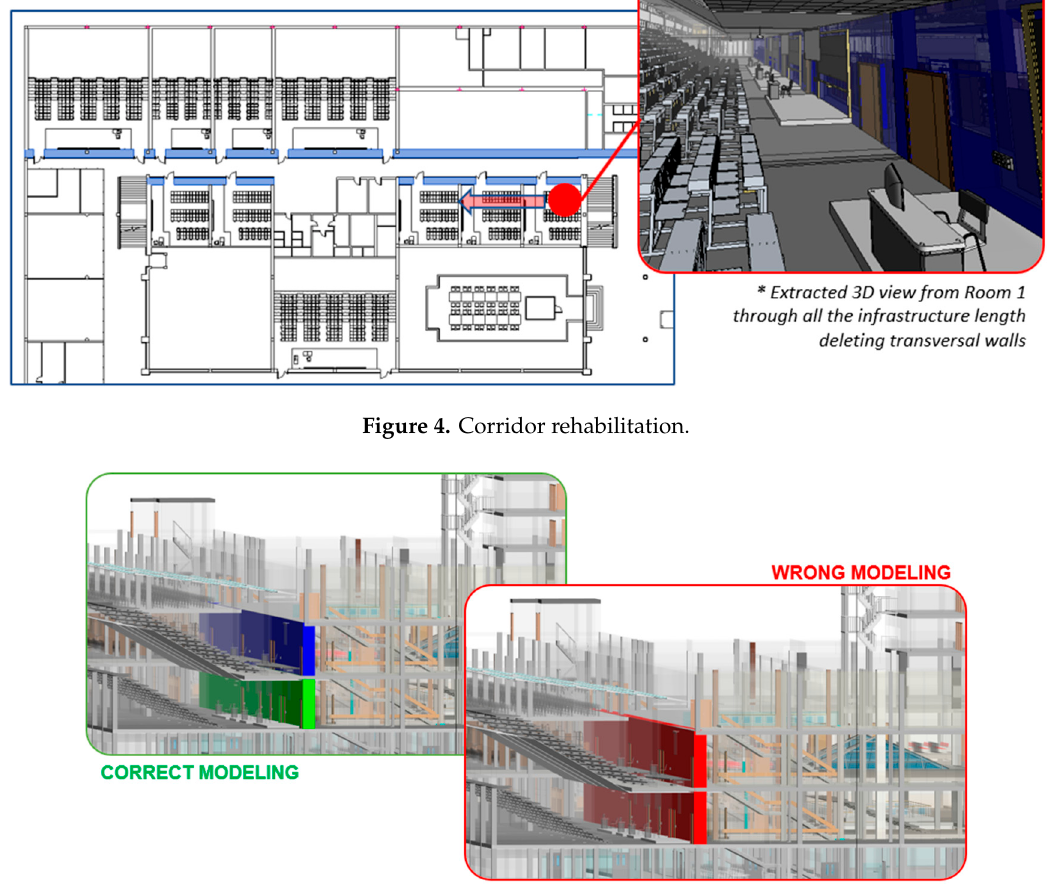
Figure 5. Correct and wrong wall modeling. Table 3. Budget based on poor modeling.